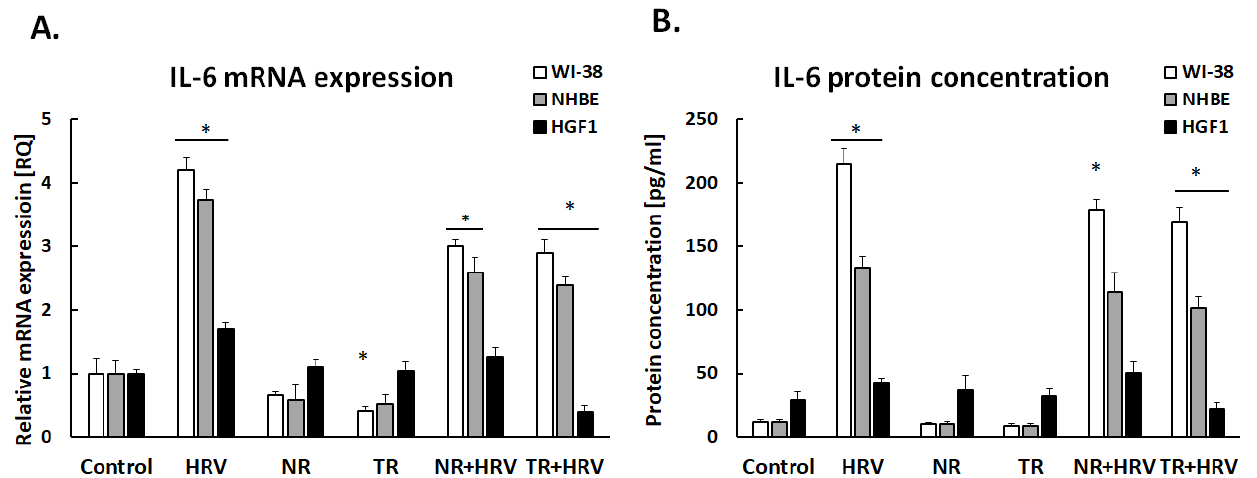
Figure 3. Leonotis nepetifolia extracts from normal (NR) and transformed (TR) roots, decreased virus-induced IL-6 expression on mRNA ( A ) and protein ( B ) levels. Data presented as mean ± SEM, * p < 0.05.